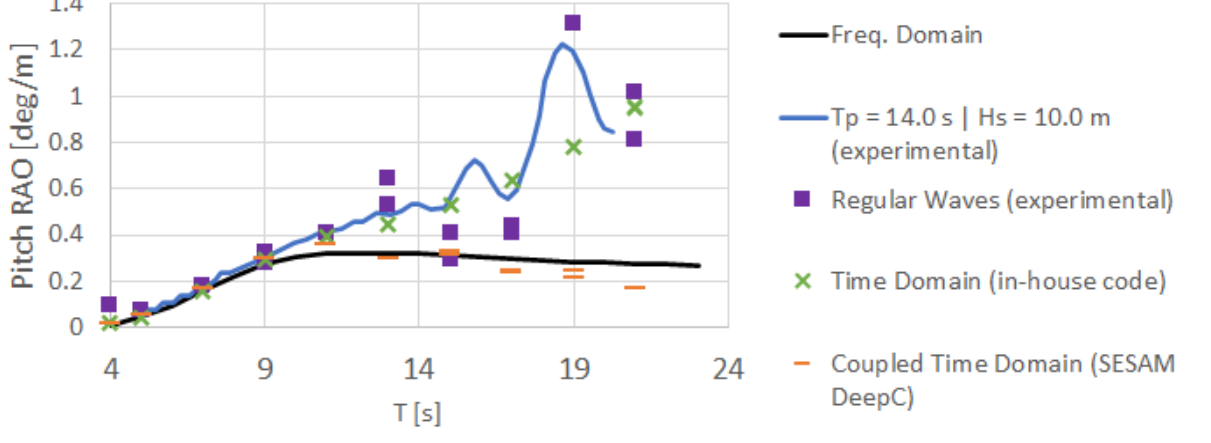
Figure 8. Pitch RAOs according to different methods.